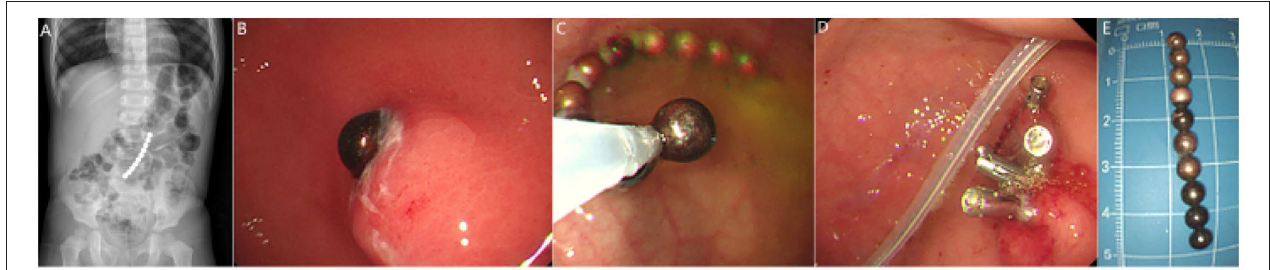
FIGURE 2 | Plain abdominal radiograph showed ingestion of ten Buckyballs (A) . Gastroscopy revealed that only one Buckyball lodged in the stomach cavity (B) . Gastroscopic removal of the Buckyballs (C,E) and primary repair of the gastric fistula using metal closure technique (D) were performed, and a nasojejunal tube was inserted for early enteral nutrition (D) .